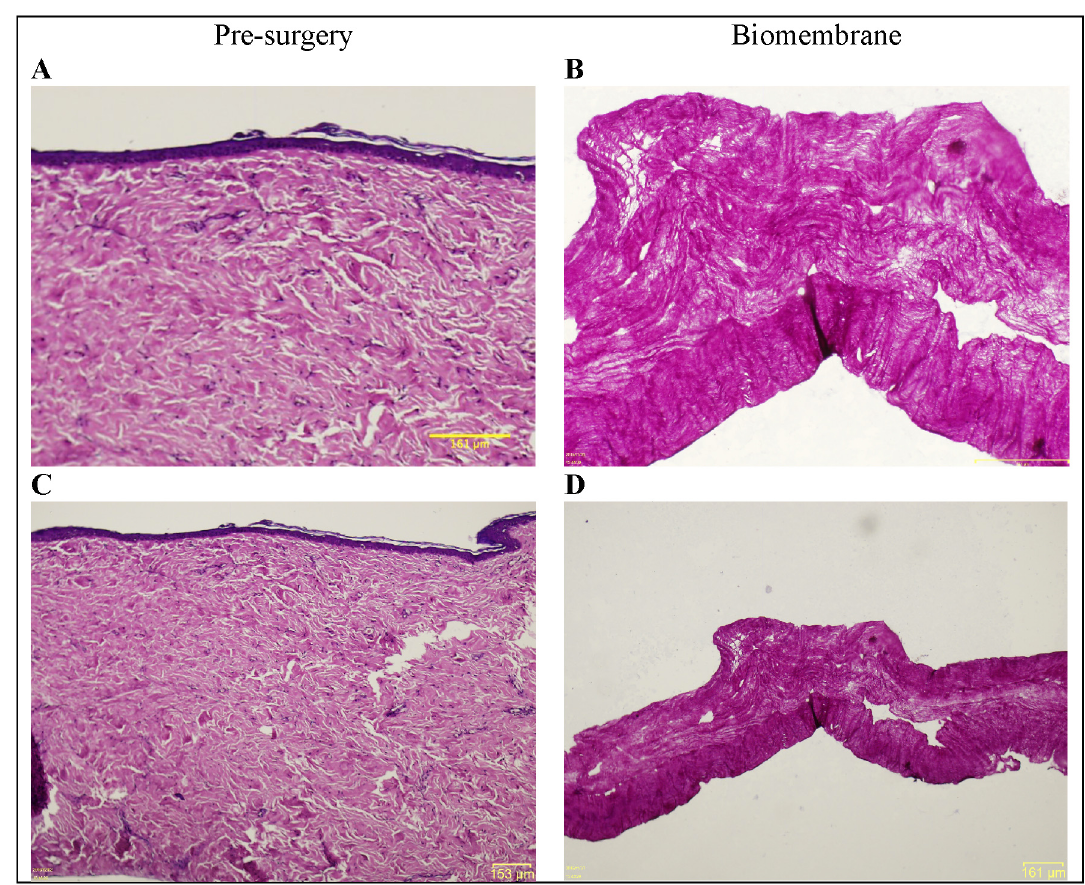
Figure 7. Hematoxylin and eosin (H&E) histomicrographs. ( A and C ; 20 × and 4 × magnification of same specimen) Hematoxylin and eosin (H&E) histomicrograph of N01’s pre-surgery tissue in the treatment area, exhibiting numerous hallmarks of fibrotic scar tissue. Epidermis is flattened, with no undulation on the surface, no epidermal rete ridges extending into the dermis, and no dermal papillae. The uppermost papillary dermis presents a dense collagenous matrix, and the lowermost, reticular dermis exhibits highly acidophilic regions with denser bundles of collagen. ( B and D ; 20 × and 4 × magnification of same specimen) H&E histomicrograph of a representative collagen biomembrane (i.e., equivalent to the implanted biomembranes prior to their utilization). Horizontally aligned thin collagen fibers with some larger pores interspersed throughout the structure, along with smaller pores with a more uniform distribution. The lowermost part of the structure presents increased acidophilicity and collagen density. This particular part of the histomicrograph shows the local elevation of approximately 100 μm in height. These elevations are part of the characteristics of the biomembrane, and are present throughout the structure, spaced approximately 2.5 mm from one